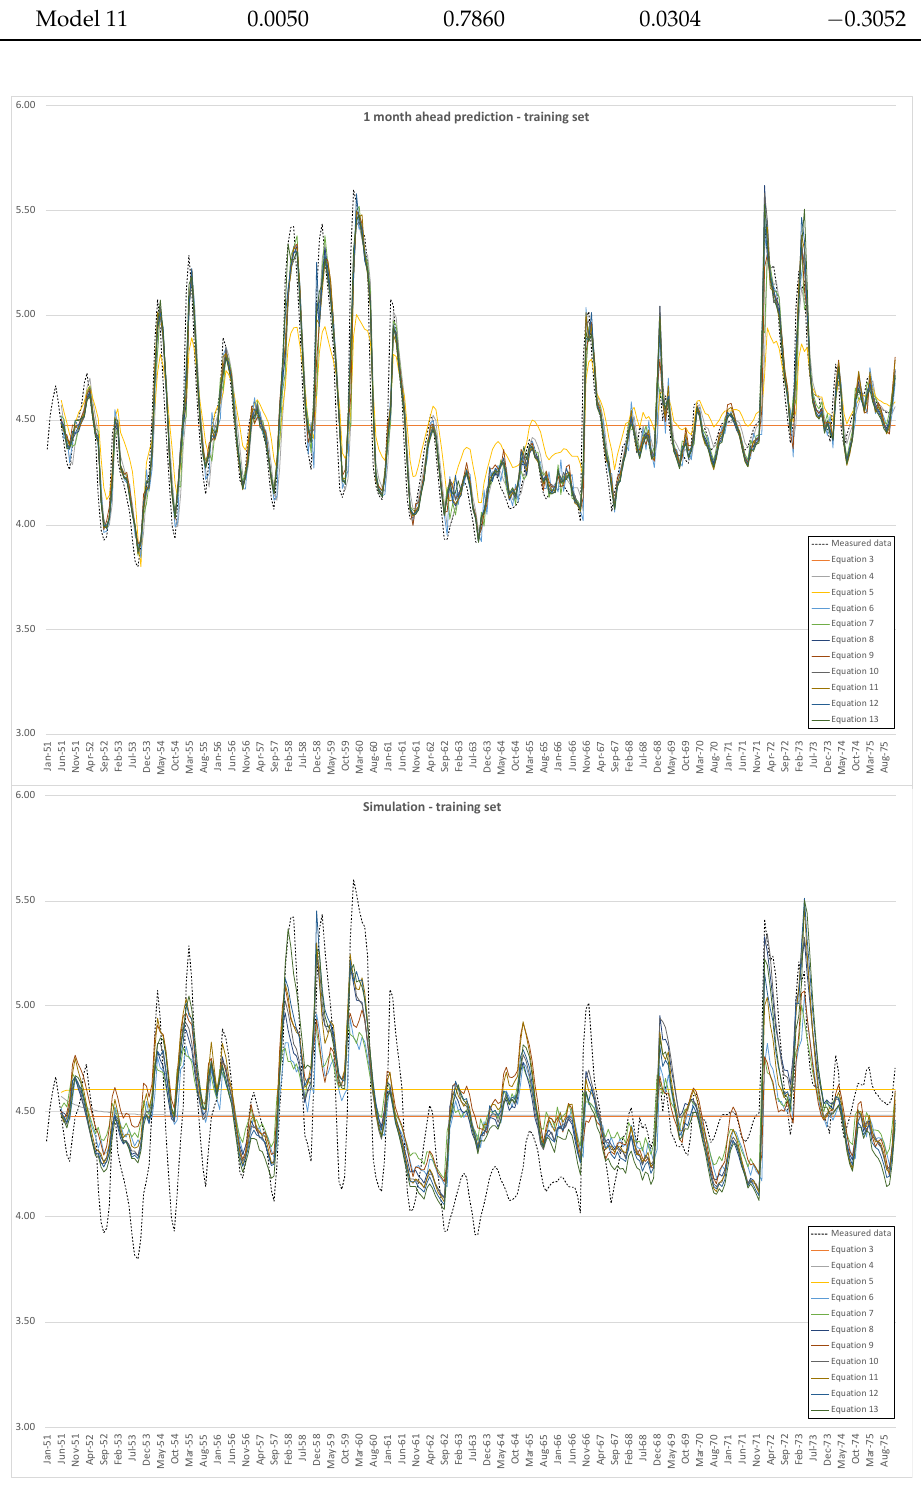
Figure 4. One month ahead prediction and simulations of EPRMOGA returned models for the training set, i.e., Casello 49, piezometric levels on the vertical axis are in m a.s.l.